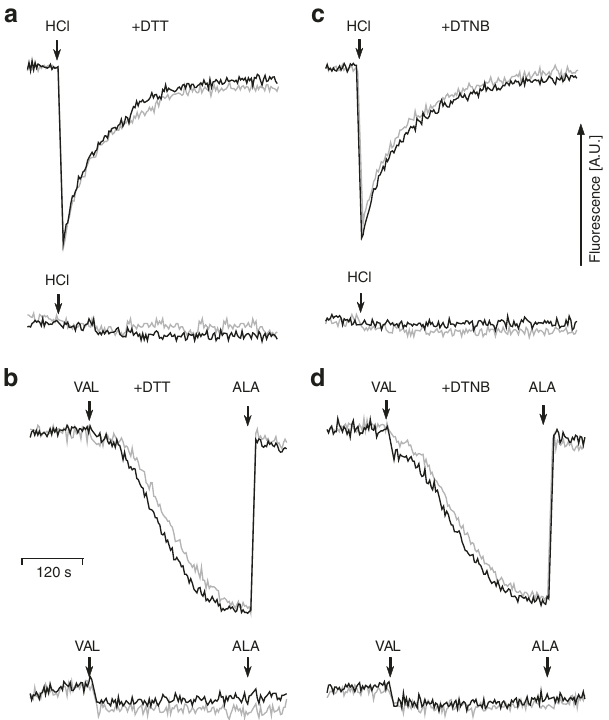
Fig. 4 The disul fi de cross-link in mutant Q133C PSST does not change proton permeability. Passive proton (H + ) uptake was monitored as 9-amino-6- chloro-2-methoxyacridine (ACMA) fl uorescence quench in proteoliposomes containing either parental (black lines) or mutant (gray lines) complex I treated with 5mM dithiothreitol (DTT) ( a , b ) or 0.1mM 5,5 ′ -dithiobis-2-